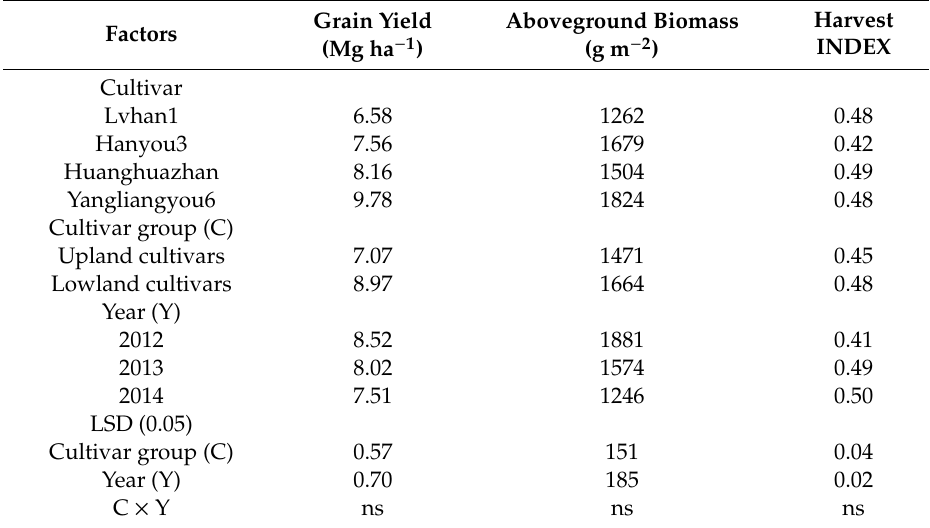
Table 3. Grain yield, aboveground biomass, harvest index of two cultivar groups including four rice cultivars under aerobic culture in all three